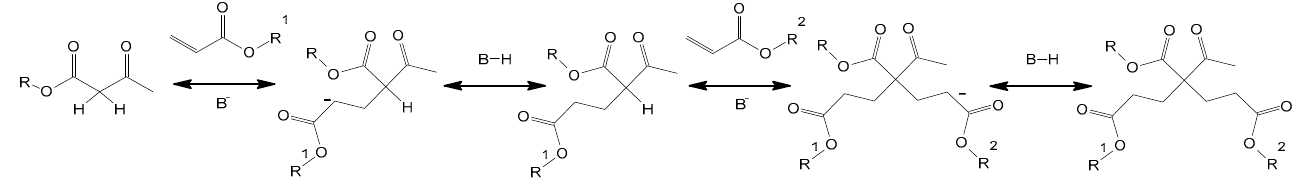
Figure 1. Mechanism of carbon–carbon Michael nucleophilic 1,4 ‐ addition reactions.